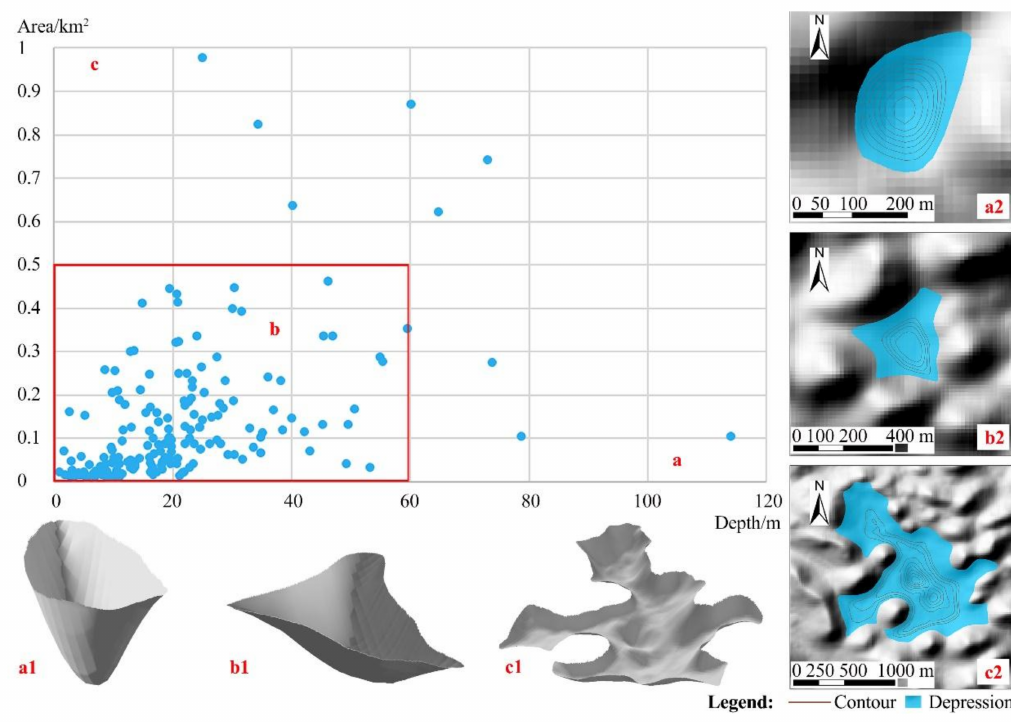
Figure 7. Plane and side morphological characteristics of depressions in study